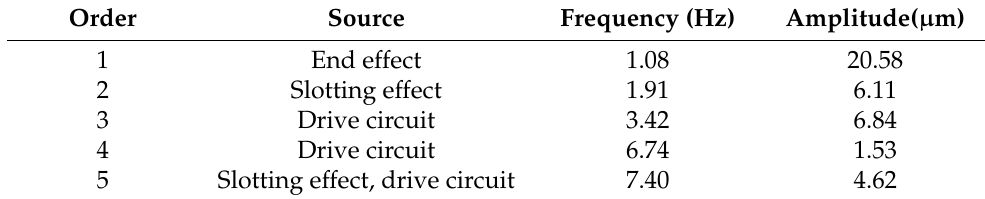
Figure 5. The spectral analysis of the thrust force in the machining process. Table 3. The original main thrust harmonics.